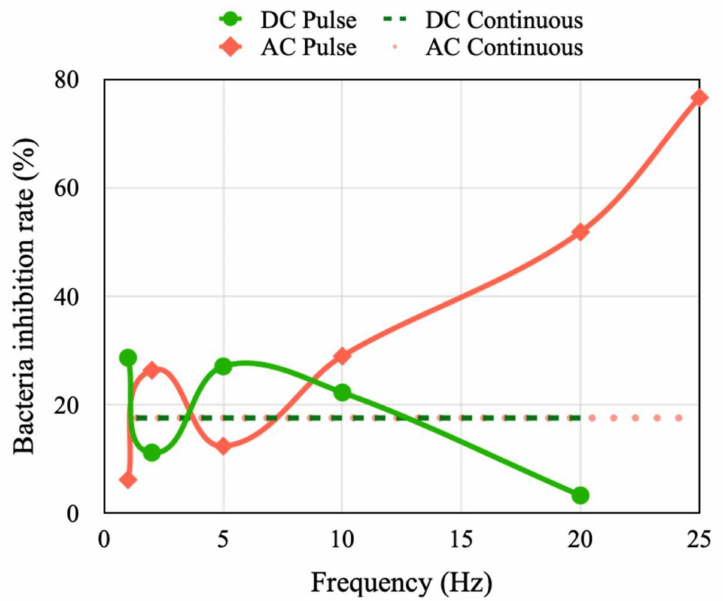
Figure 10. Inhibition rate of E. coli activity under DC and AC continuous and pulse stimulation conditions with different frequencies.